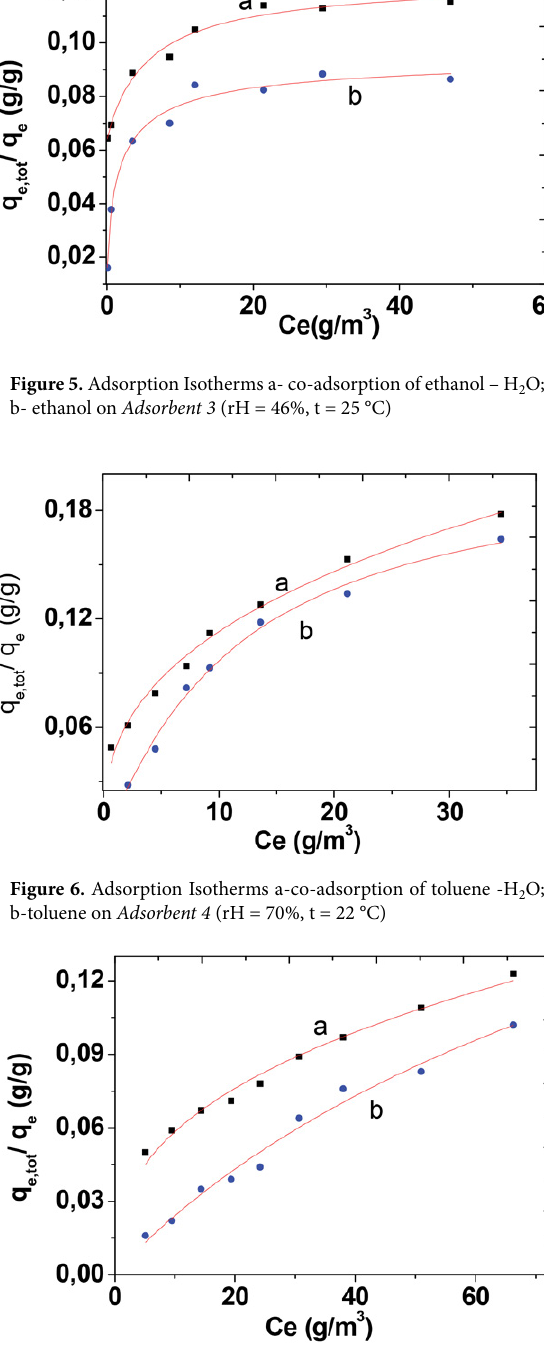
Figure 4. Adsorption Isotherms a- co-adsorption of methanol-H 2 O; b- methanol on Adsorbent 3 ( rH = 55%, t = 25 °C)